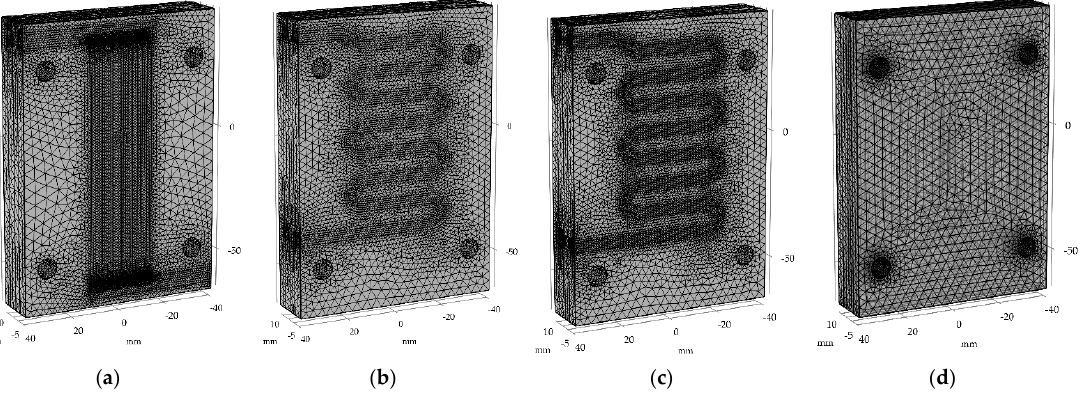
Figure 11. The final meshes for wax injection molds with: ( a ) finned channels, ( b ) square channel, ( c ) round channel, ( d ) no cooling channels.